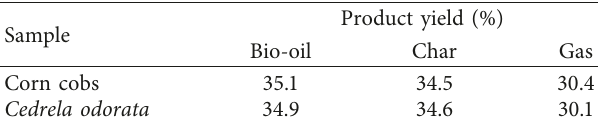
Table 1: Products yield of pyrolysis of corn cobs and Cedrela odorata biomass.